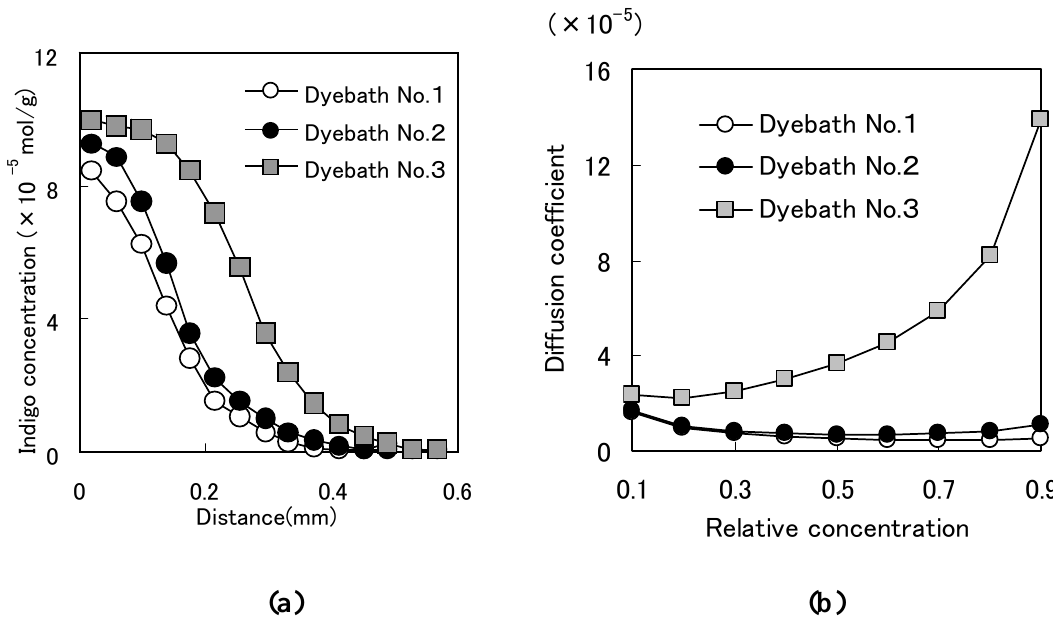
Figure 8. (a) Diffusion profiles of indigo [8]. (b) Diffusion coefficients and relative